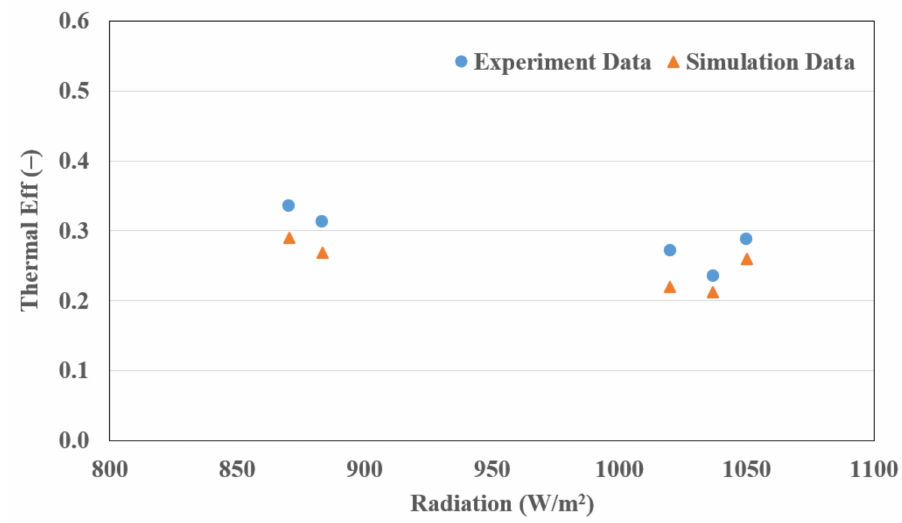
Figure 8. Comparison of thermal efficiencies for experimental and simulation assessments.